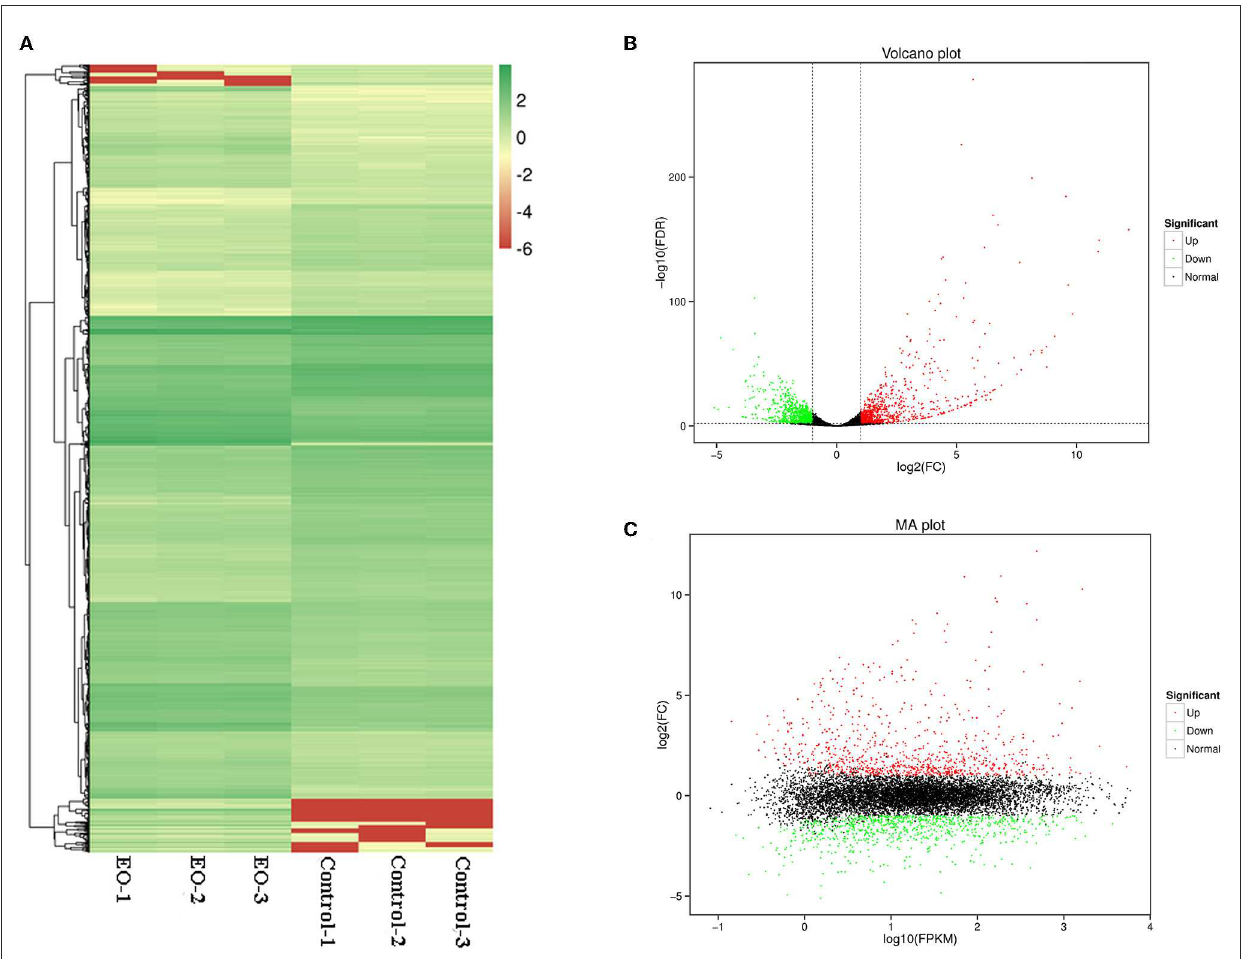
FIGURE6 Differentially expressed genes (DEGs) analyzed in C. gloeosporioides cells for global comparison of transcription profiles (clove EO treatment vs. control). (A) Heatmap. (B) Volcano plot. (C) MA